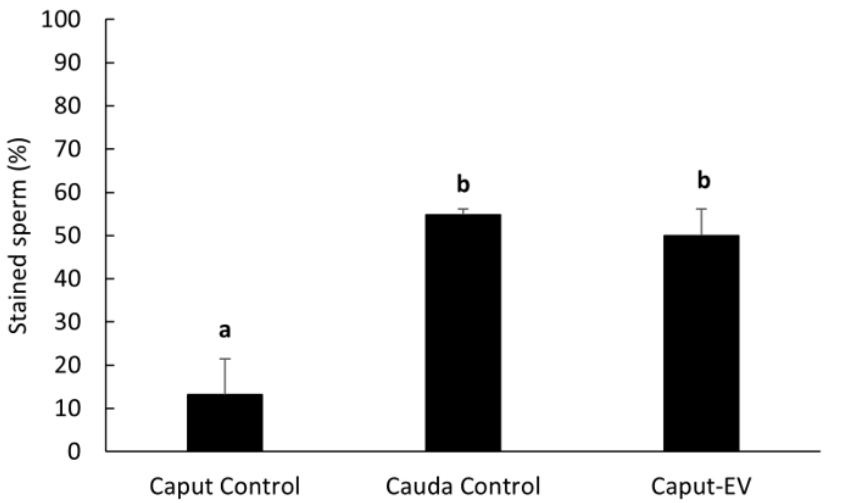
Figure 7. Percentages (mean ± SEM) of spermatozoa positively stained for LGALS3BP in the centrosome region. “Caput Control” spermatozoa were incubated for 3 h with plain buffer medium; “Cauda Control” spermatozoa were not exposed to EVs; “Caput ‐ EV” spermatozoa were incubated for 3 h with EVs (n = 5 males per treatment). Bars with different letters significantly differ ( p ≤ 0.01).